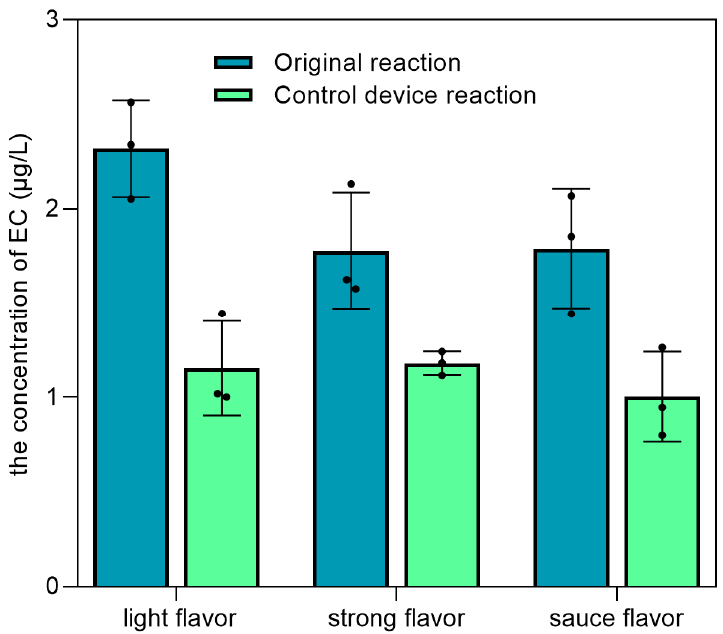
Figure 9. The concentration of EC in distilled spirits after the optimization of distillation for different flavors of Baijiu.